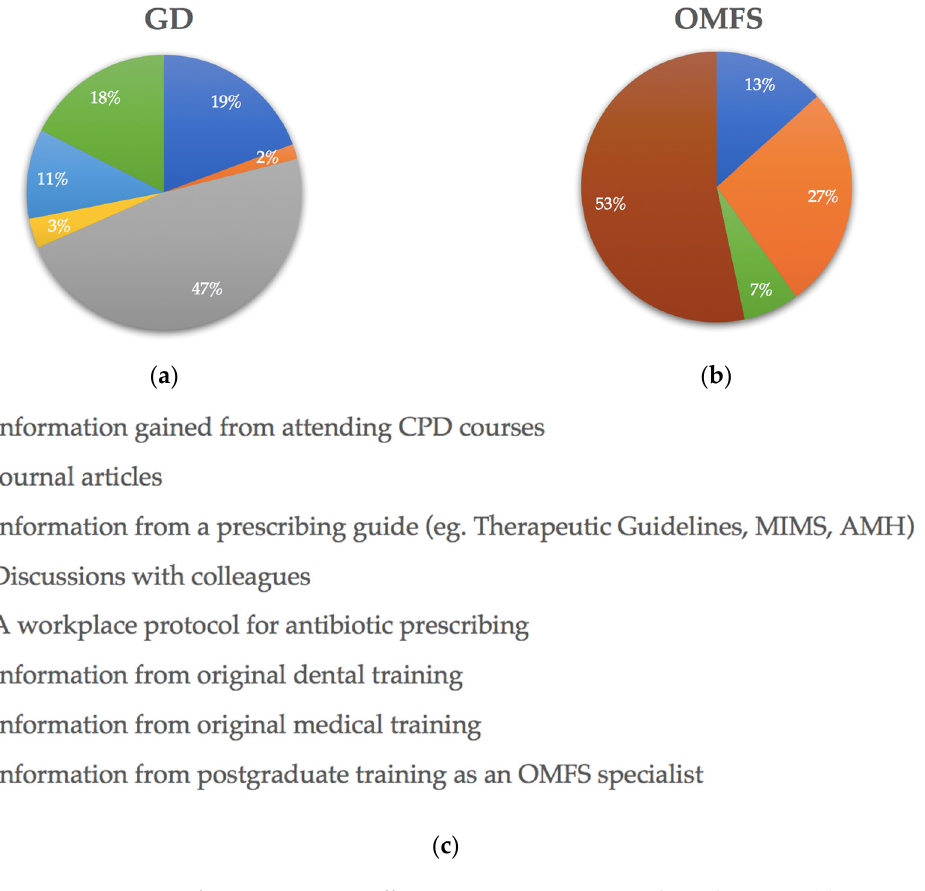
Figure 2. Percentage (%) use of prescribing guides within GD ( n = 60) and OMFS ( n = 16) groups. 2.5. Adverse Drug Reactions Over half of the OMFSs (52.9%) had previously observed adverse drug reactions to antibiotics that required medical referral. This was significantly higher compared to the GD group, where only 10.0% of practitioners had observed these reactions. Reactions observed by respondents included anaphylactic reactions to penicillin/amoxicillin and cephalosporin, tetracycline allergies, skin rashes, erythema multiforme, and death. 3. Discussion This study investigated the use of therapeutic and prophylactic antibiotics by general dental practitioners and oral and maxillofacial surgeons with respect to third molar surgical extractions and dental implant placement. Discrepancies were observed between the antibiotic protocols of different practitioner groups for both case scenarios. The majority of OMFSs (61.1%) opted to prescribe antibiotics for surgical third molar extraction. This was significantly greater than the GD group (23.5%) ( p < 0.01). For single dental implant placement, most OMFSs (72.2%) and GDs (62.1%) prescribed antibiotics routinely. The differences between the antibiotic protocols of the GD and